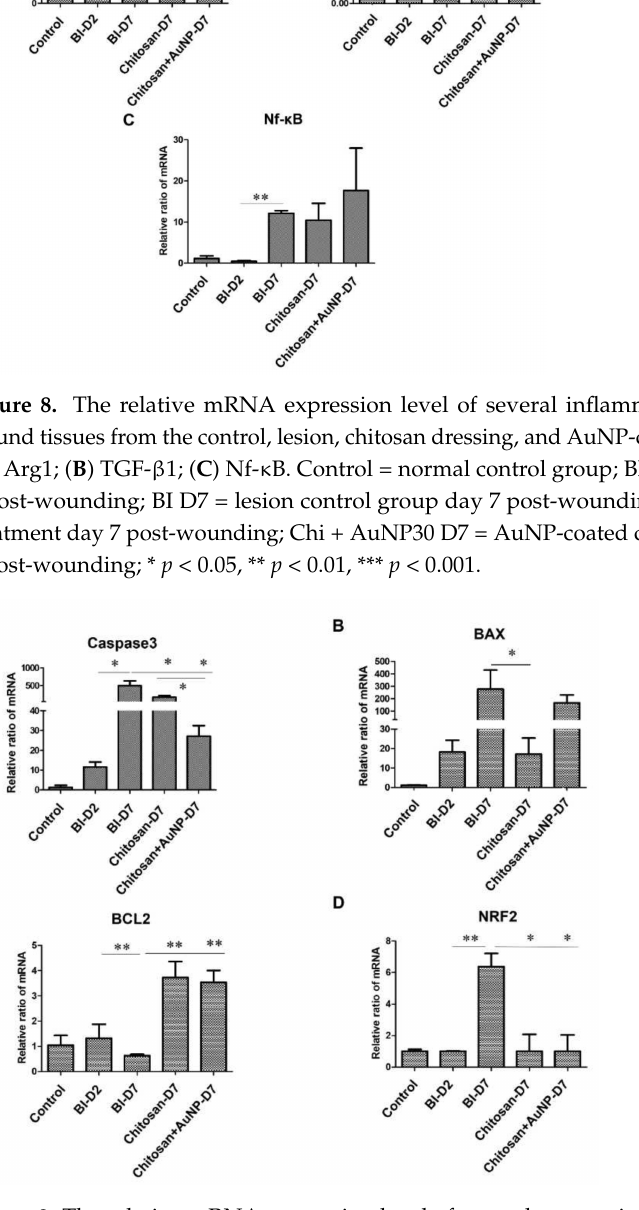
Figure 9. The relative mRNA expression level of several apoptosis biomarkers in rat burn wound tissues from the control, lesion, chitosan dressing, and AuNP-coated chitosan dressing groups. ( A ) Caspase-3; ( B ) BAX; ( C ) BCL2; ( D ) NRF2. Control = normal control group; BI D1 = lesion control group day 1 post-wounding; BI D7 = lesion control group day 7 post-wounding; Chi D7 = chitosan dressing treatment day 7 post-wounding; Chi + AuNP30 D7 = AuNP-coated chitosan dressing treatment day 7 post-wounding; * p < 0.05, ** p <